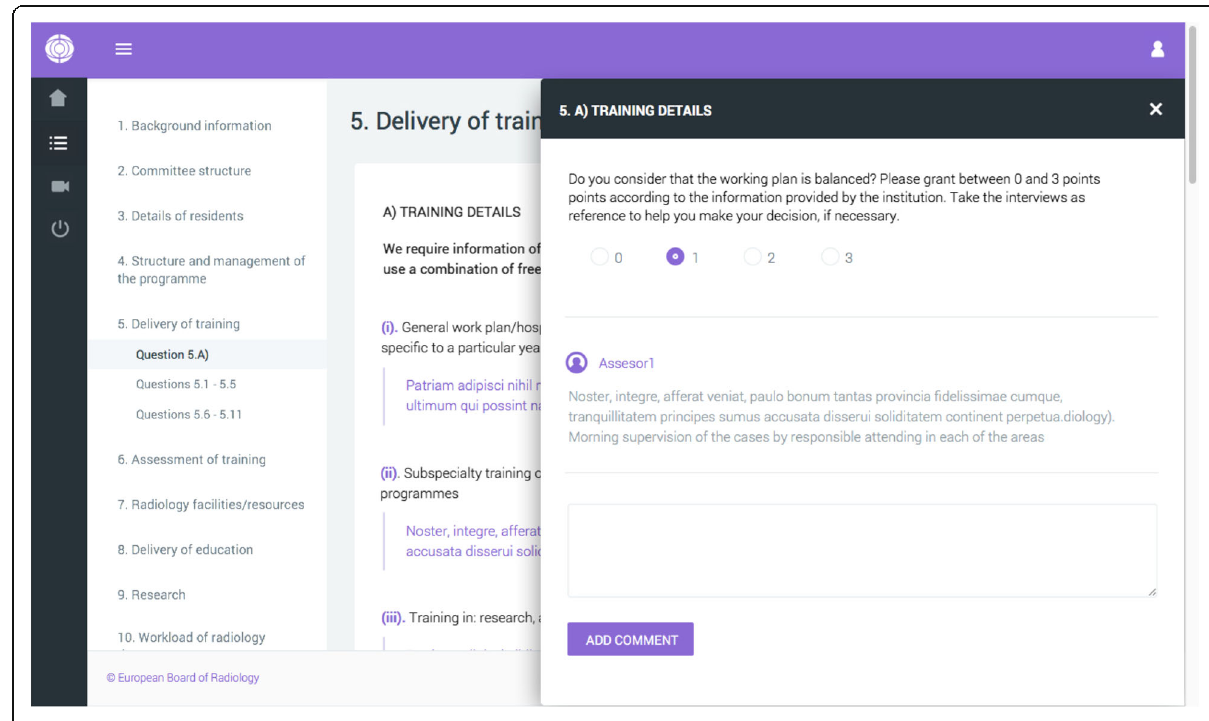
Fig. 2 ETAP 2.0 platform (Back-end for assessors)